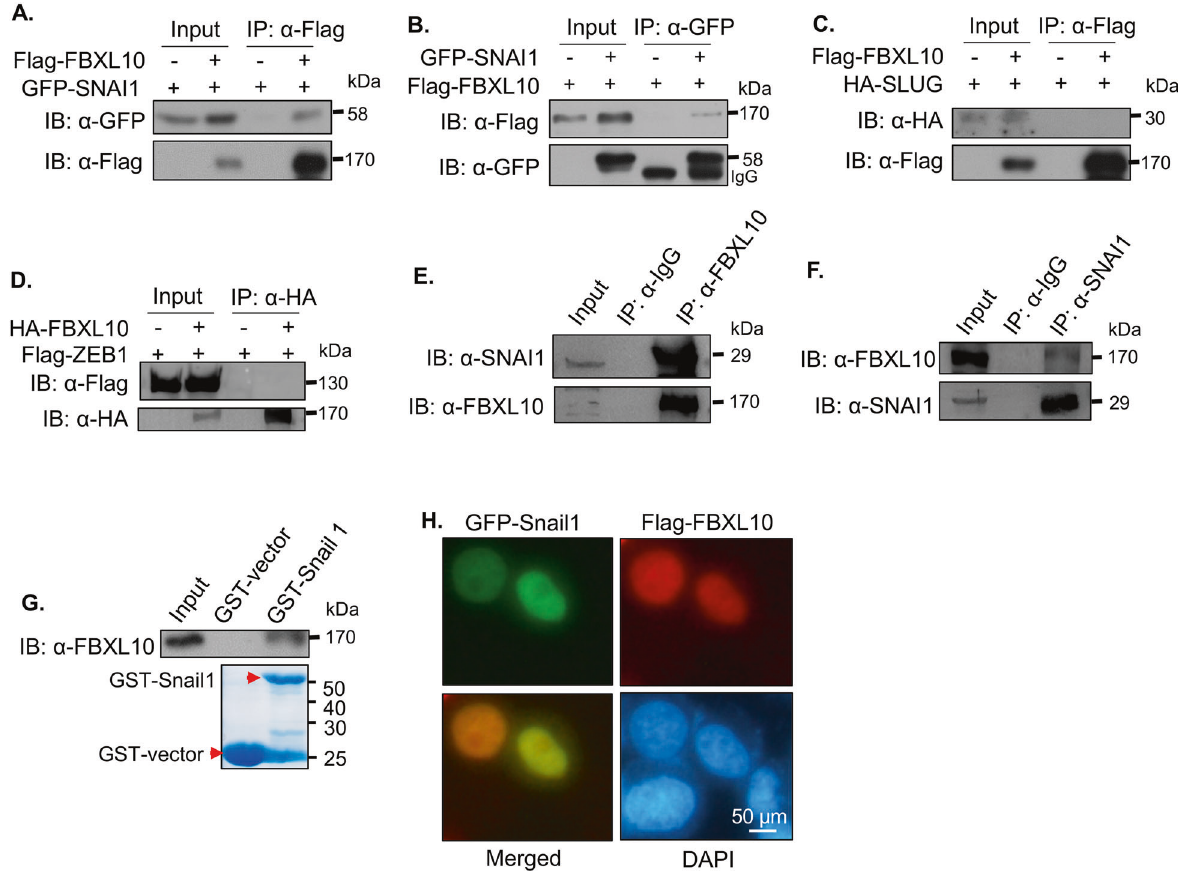
Fig. 4 The interaction between FBXL10 and SNAI1. A , B CoIP assay showed the interaction between exogenous FBXL10 and SNAI1 in HEK293T cells. C , D CoIP assay was conducted to explore the interaction between FBXL10 with SLUG ( C ) and ZEB1 ( D ) in HEK293T cells. E , F . CoIP assay tested the endogenous interaction between FBXL10 and SNAI1 in ZR-75 – 30 cells. G GST-pulldown assay showed the puri fi ed SNAI1 had physical interaction with endogenous FBXL10 from MCF7 cells. H Immuno fl uorescence assay showed the colocalization of FBXL10 (red) and SNAI1 (green) in MCF7